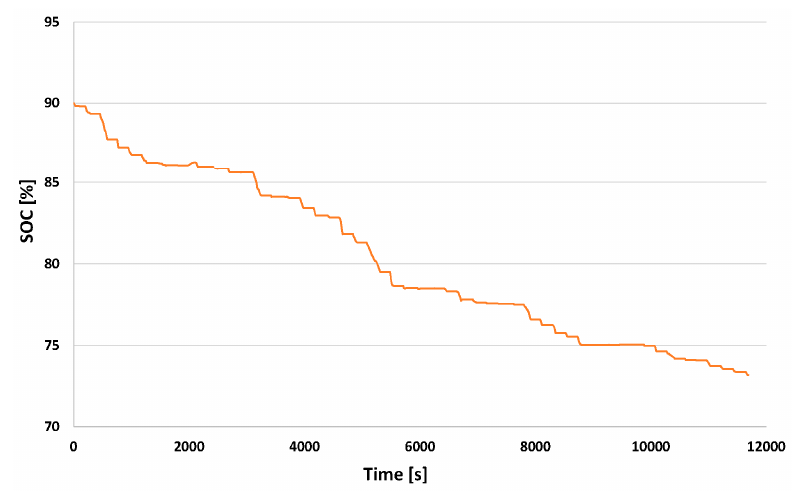
Figure 18. State of charge consumption during the cycle in EV mode.